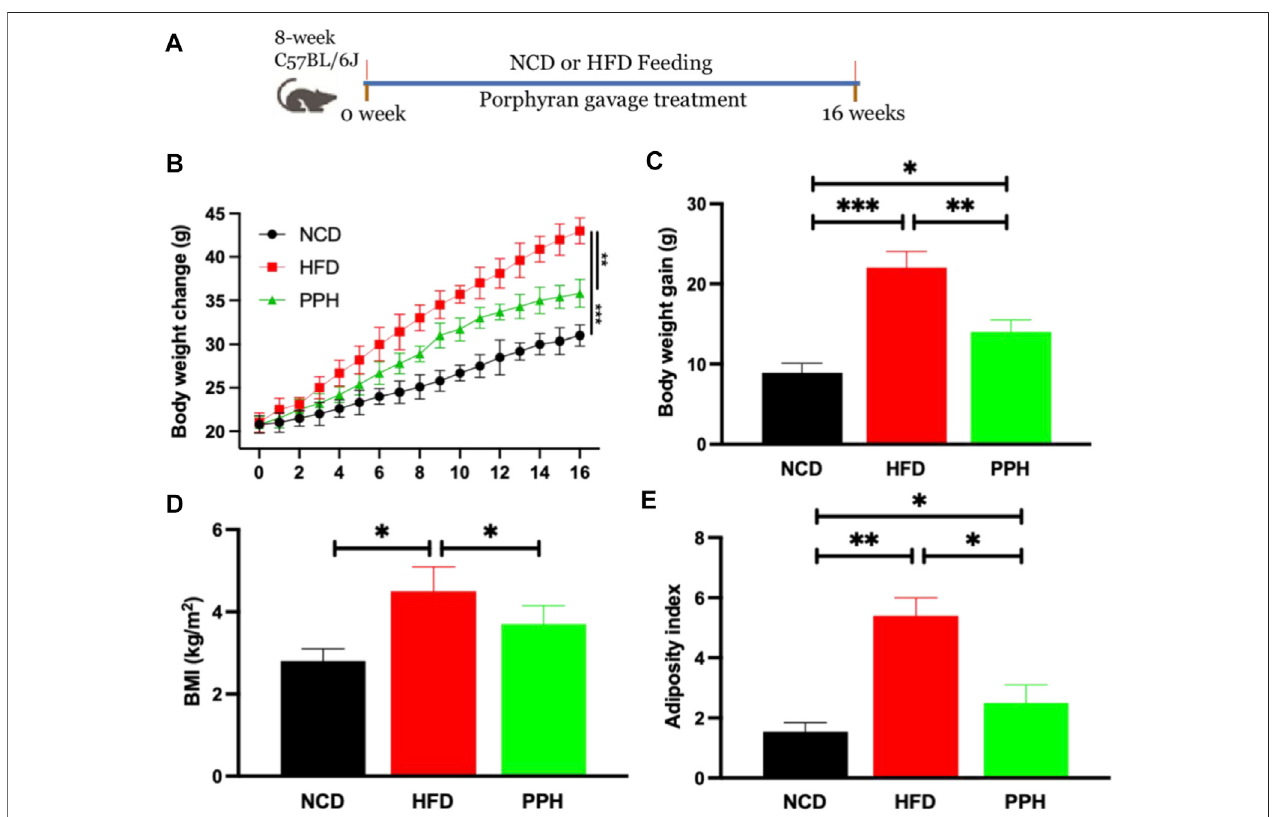
FIGURE1| PPHalleviatedHFD-inducedobesityinmice.Schematicdiagramoftheanimalexperiment (A) ;bodyweightchange (B) ;bodyweightgain (C) ;BMI (D) , calculated by body weight/height 2 ; adiposity index (E) . * p < 0.05, ** p < 0.01, and *** p < 0.001.